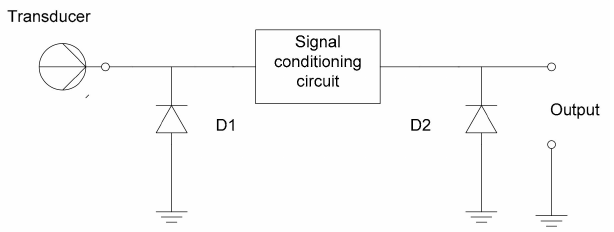
Figure 5. Passive electrostatic discharge (ESD) protection employing